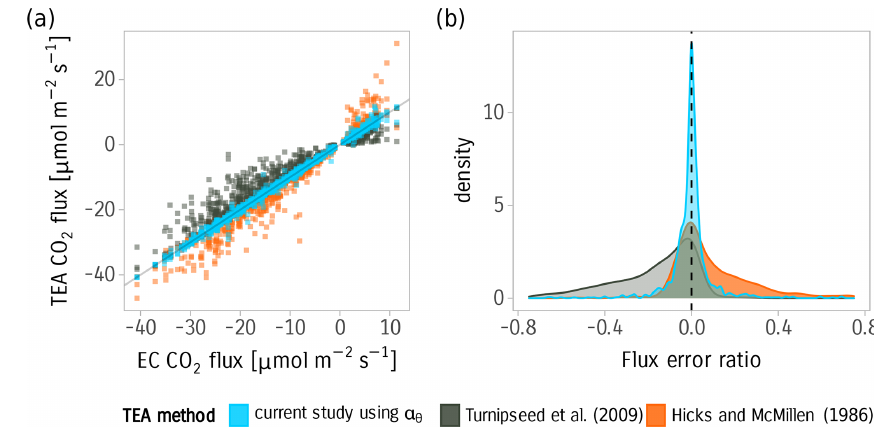
Figure 1. (a) Comparison of different equations of TEA flux calculation against a reference EC flux. Data were obtained from high-frequency measurements over 12d from 15 June 2020 to 26 June 2020 and included an added random w offset in the range − 0 . 25 to 0.25ms − 1 . Colors represent different formulas. (b) Kernel density estimates of the flux error ratio using the three different